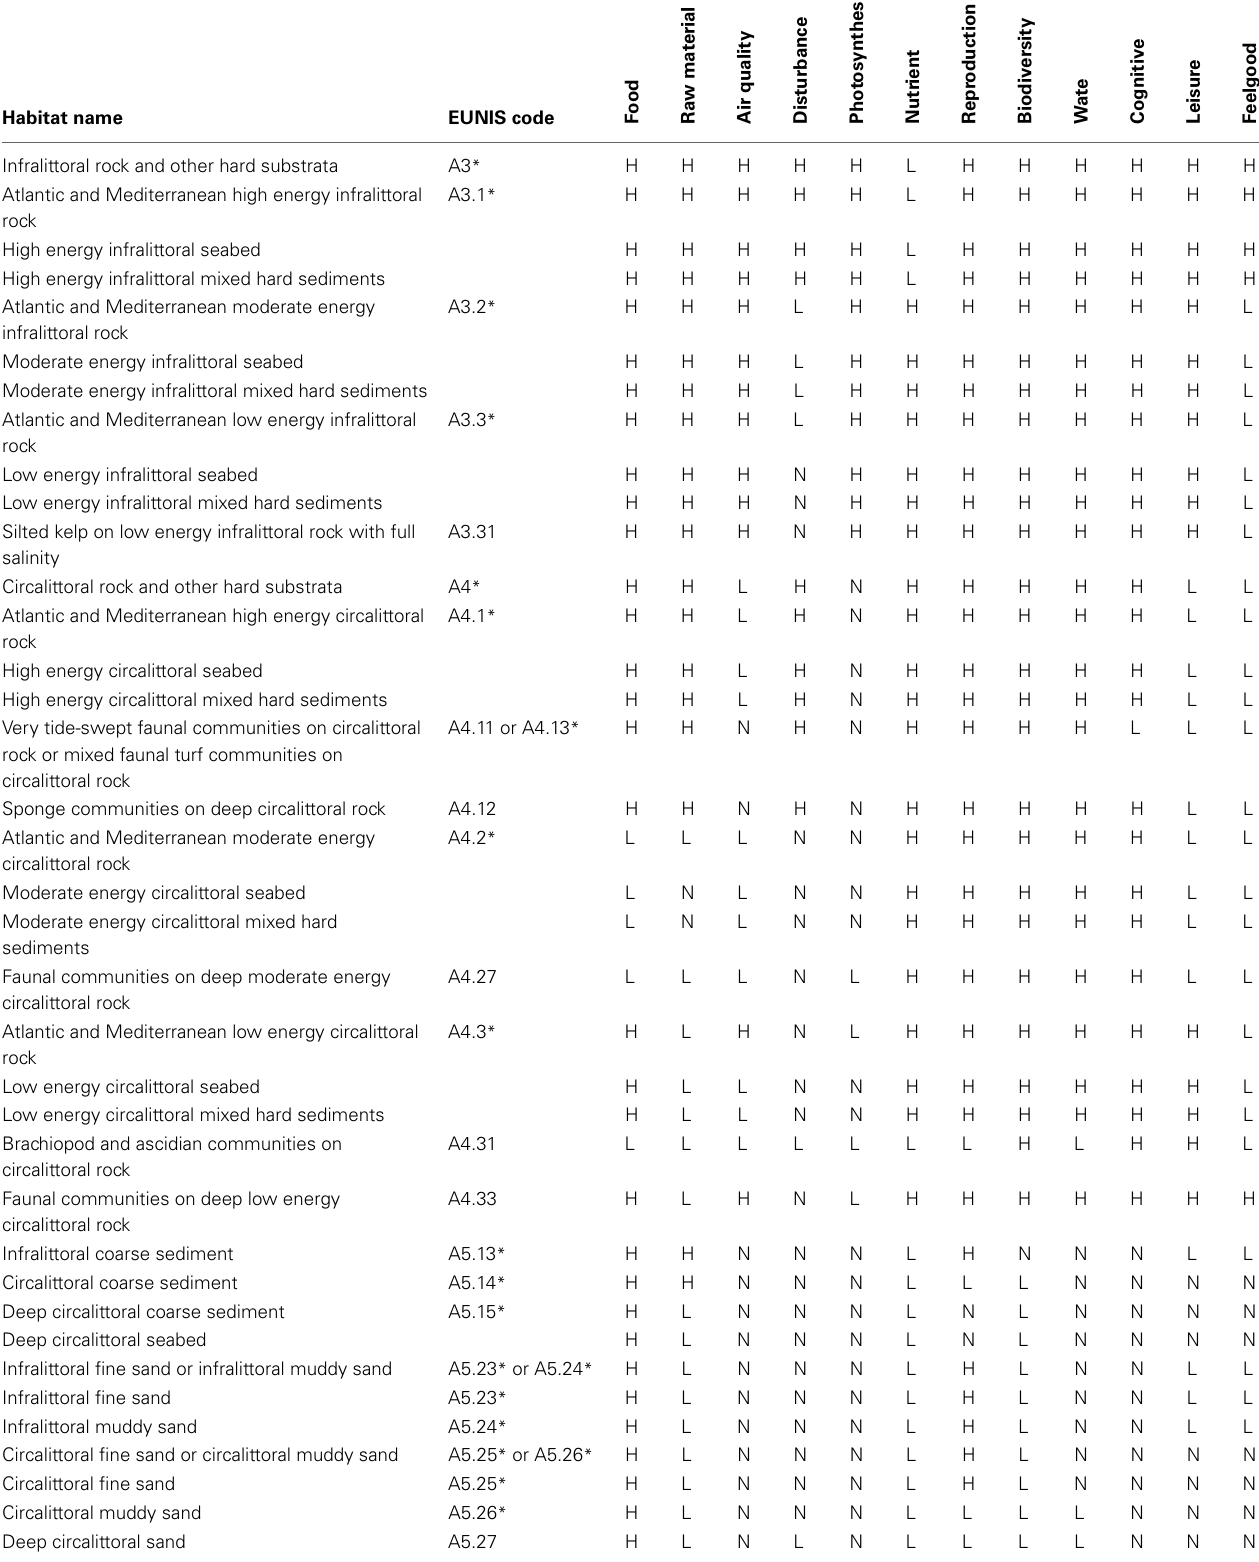
Table 2 | Ecosystem services assessment for each habitat and seabed feature type (H, high; L, low; and N,